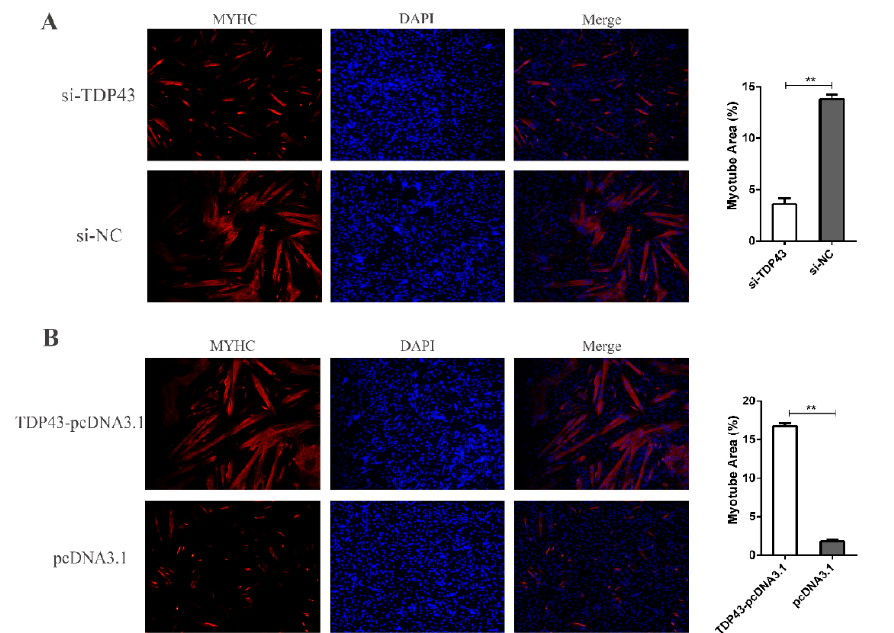
Figure 3. ( A ) Representative photographs of MYHC immunofluorescence staining in PSCs differentiated for 24 h showing that knockdown of TDP43 significantly decreased the MYHC expression level. ( B ) Representative photographs of MYHC immunofluorescence staining in PSCs differentiated for 24 h showing that TDP43-pcDNA3.1 significantly increased the MYHC expression level. Mean values ± SD, n = 3. * means p < 0.05, ** means p < 0.01.